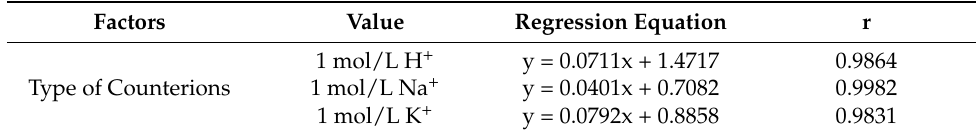
Table 10. Boyd model fitting on type of counterions.